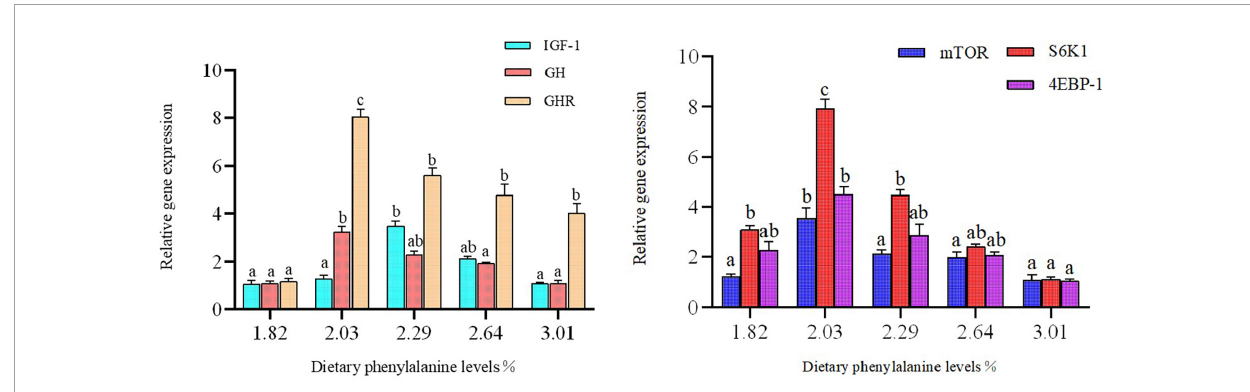
FIGURE4 Growth gene expression of the intestine. Lowercase letters (a, b, or c) indicate a significant effect of liver growth on gene expression ( p < 0.05). GH, growth hormone; IGF-1, insulin growth factor 1; GHR, growth hormone receptor; 4E-BP, eukaryotic initiation factor 4E-binding proteins; S6K1, S6 kinase